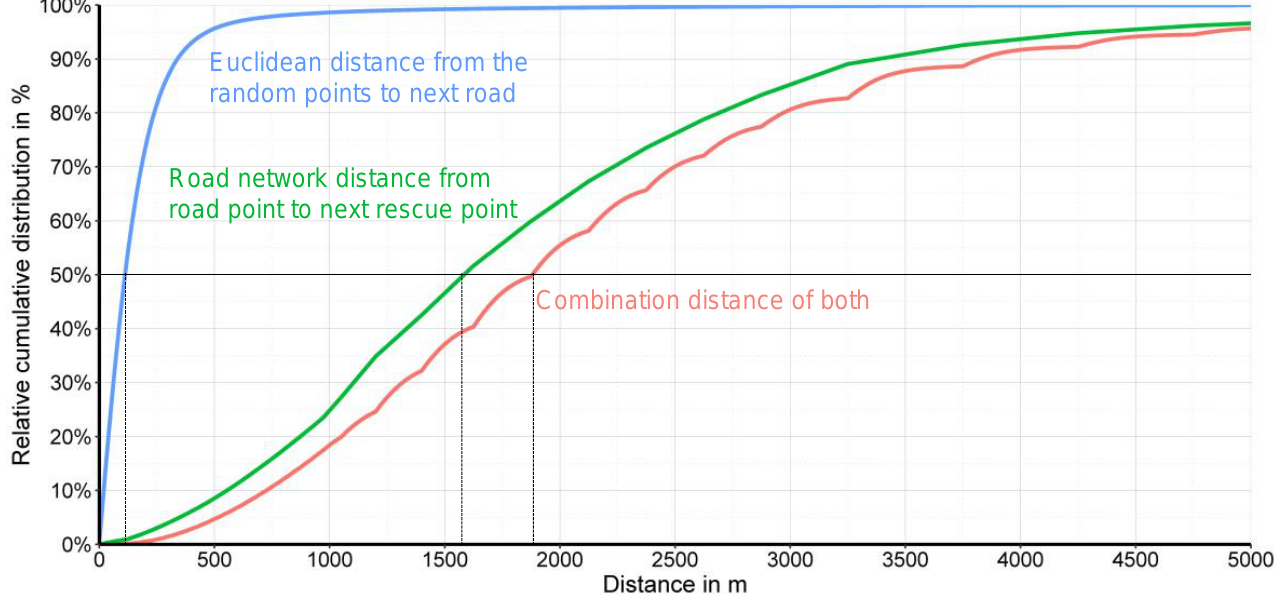
Figure 8. Relative cumulative distribution of the Euclidean distance from random points to the nearest Figure X. Euclidean distance from the random points to next road (blue line); Road road (blue line); road network distances from a road point to the nearest rescue point (green line); network distances from road point to next rescue point (green line); a pairwise and pairwise combination of both (red line) as an example for the federal state Bavaria (n = 364,271). combination of both (red line) This indicator was calculated for the 25% quantile: 1208 m (50% quantile: 1880 m; 75% quantile: 2718 m; 95% quantile: 4823 m) as the transport distance to the nearest rescue point. It is apparent that the part travelled on the road is clearly